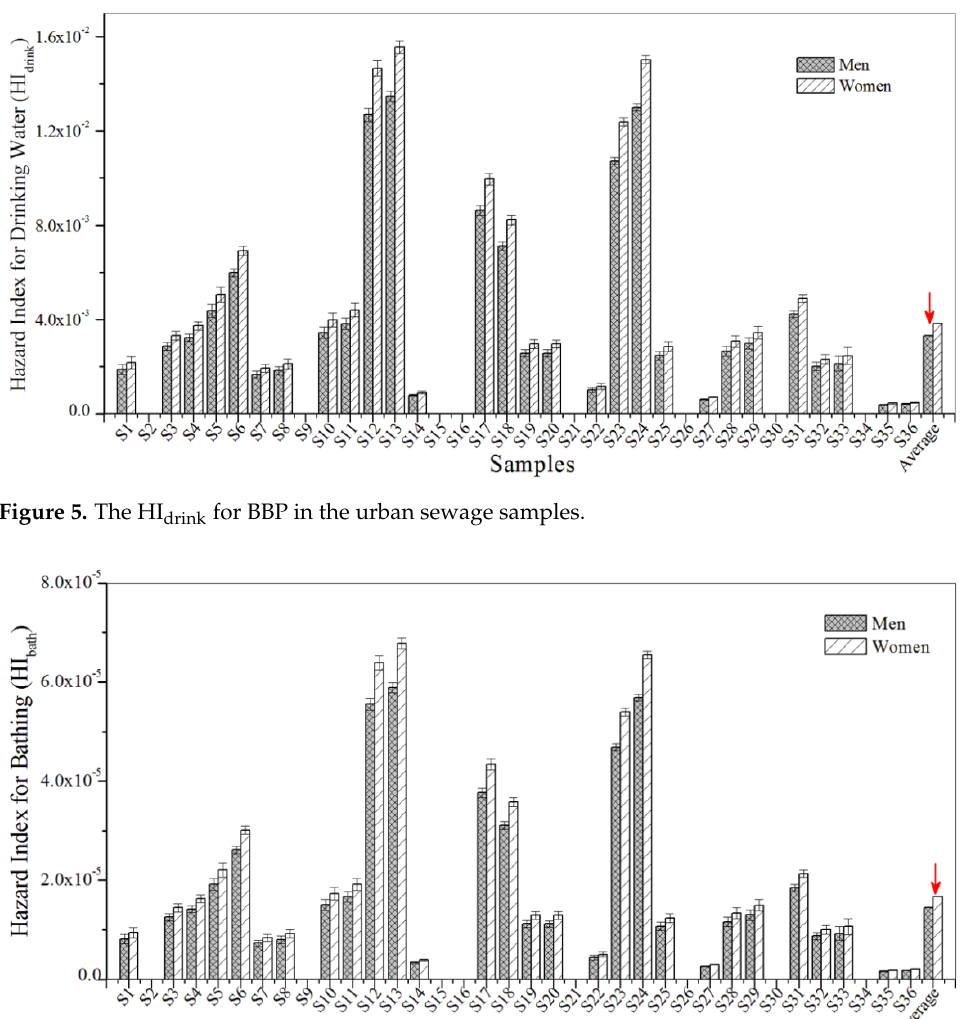
Figure 4. The RQ for BBP in the urban sewage samples.